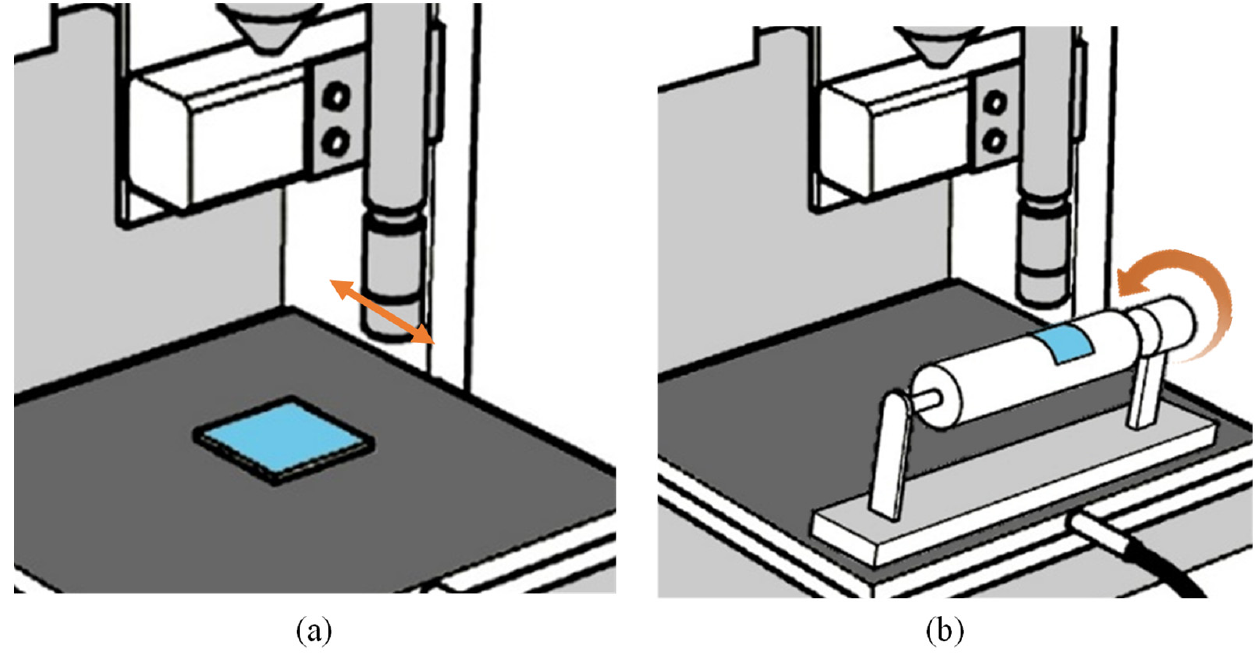
Figure 4. Spray procedure by using a multi-spray coater (( a ): low speed, ( b ): high speed). The printing was carried out on a substrate moving from 200 to 2000 mm/s. In both cases, the distance between the nozzle and the substrate was 14 cm. Finally, a sample was prepared by fixing the ink injection amount to 20 mL.